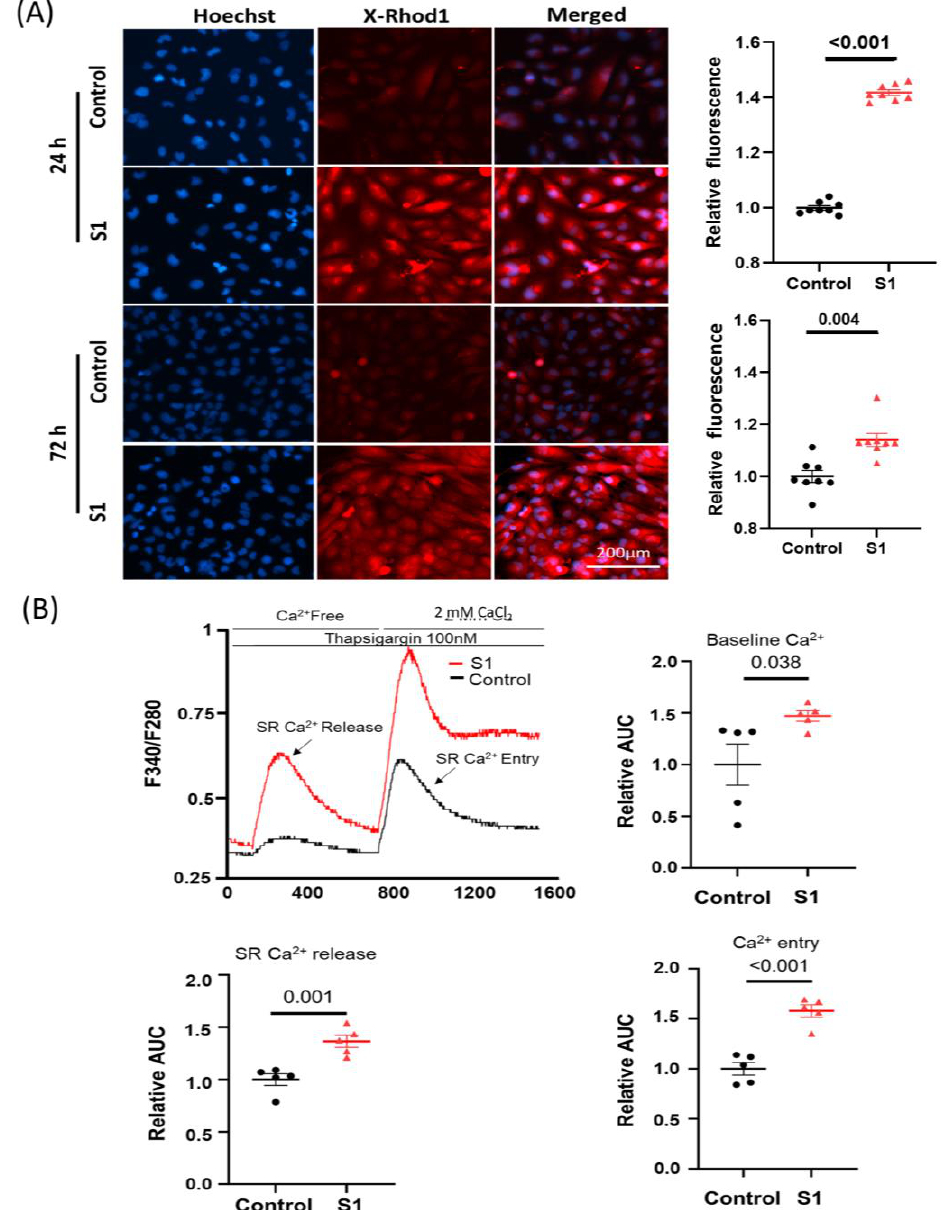
Figure 3. The effects of S1 on AC16 TOM20 and mitochondrial calcium (mCa 2+ ) levels after 24 h and 72 h treatments were evaluated using ICC and X-Rhod-1 staining. ( A ) S1 protein increased mCa 2+ levels in both 24 h- and 72 h-treated cells compared to control groups ( n = 8 independent experi- ments). ( B ) S1 protein increased baseline cytosol Ca 2+ level, SR-Ca 2+ release, and Ca 2+ entry ( n = 5 independent experiments) after treatment for 72 h in AC16. Paired t -test was used for comparing control and treated cells.